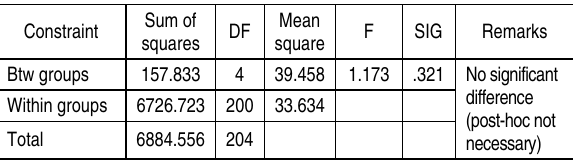
Table 3. One way ANOVA showing differences among stakeholders for agricultural